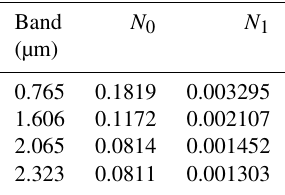
Table 3. Noise parameters for the geoCARB bands. The units of N 0 and N 1 are nW(cm 2 srcm − 1 ) − 1